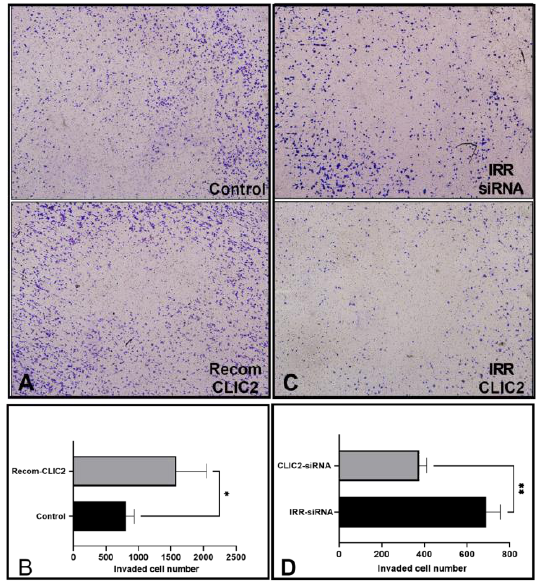
Figure 5. Modulatory effects of CLIC2 on microglial invasion activity. Recombinant CLIC2 accelerated the invasion of microglial cells. n = 4. CLIC2 silencing decreased the invasive activity of microglia ( n = 3). Data are expressed as mean ± SD. Unpaired two-tailed t -test were applied. * p < 0.05 and ** p < 0.01 indicate significant differences between the two groups ( B , D ). Representative photographs for each group ( A , C